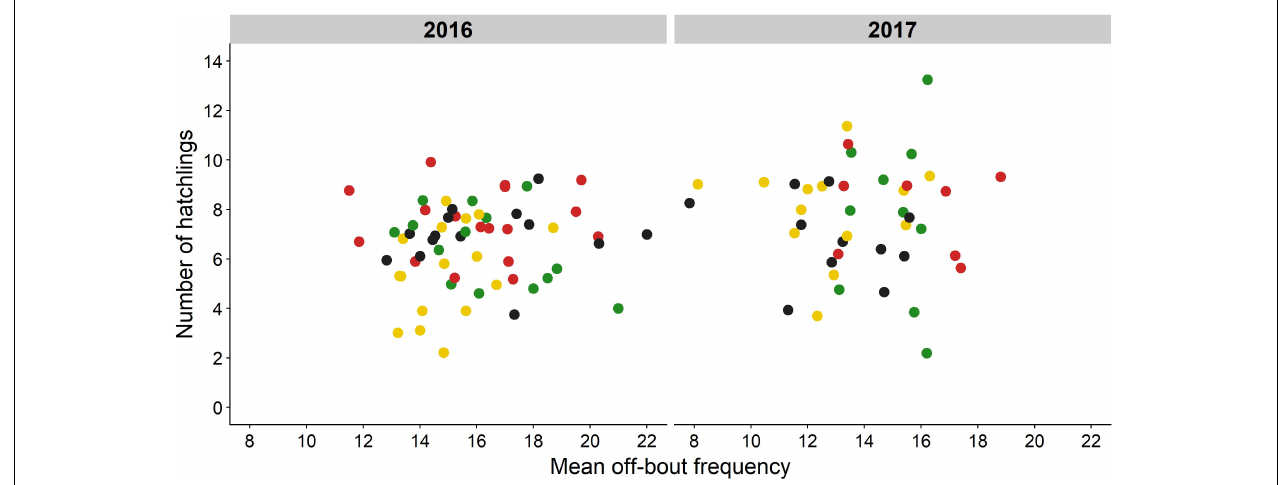
FIGURE 6 | No relation between off-bout frequency and number of hatchlings. Mean off-bout frequency during the incubation period is shown for each monitored nest in relation to number of hatchlings (green: green light, red: red light, yellow: white light, black: no light). Number of hatchlings could not be explained by off-bout frequency, average night nest temperature, or incubation length ( P > 0.05, Supplementary Table 8